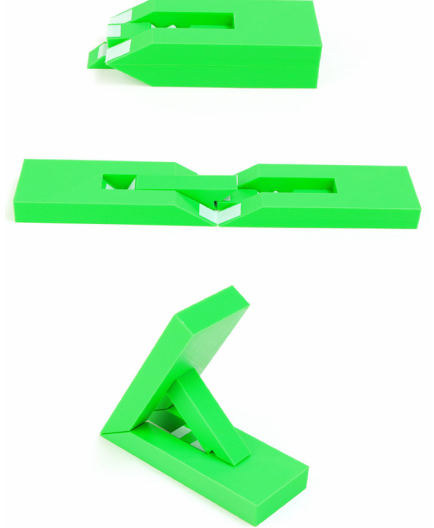
Figure 17. Flat-foldable planar deploying strut ThUDS with offset crease joint. Flat foldability is in the opposite direction of deploy- ment. All joints lie on the bottom plane. Shown in flat-folded, flat, and deployed